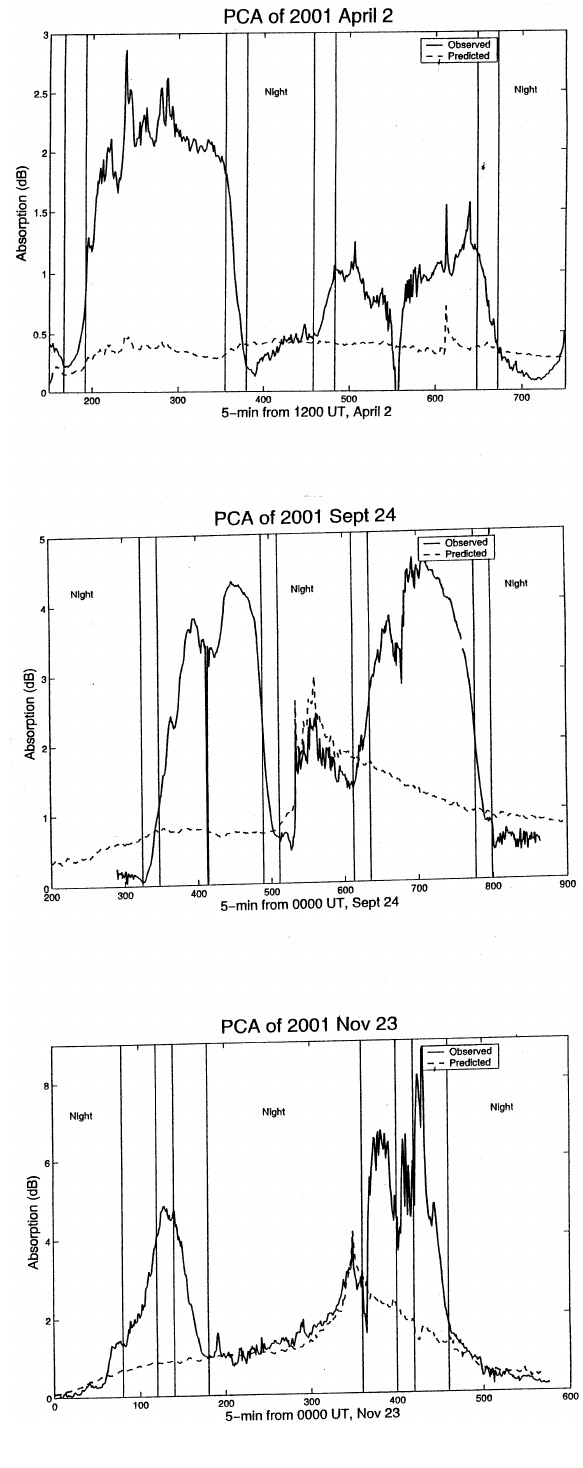
Fig. 12. Predicted absorption for the night periods of the 2002 events beginning 2 April, 24 September, and 23 November. The vertical lines are as on Fig.